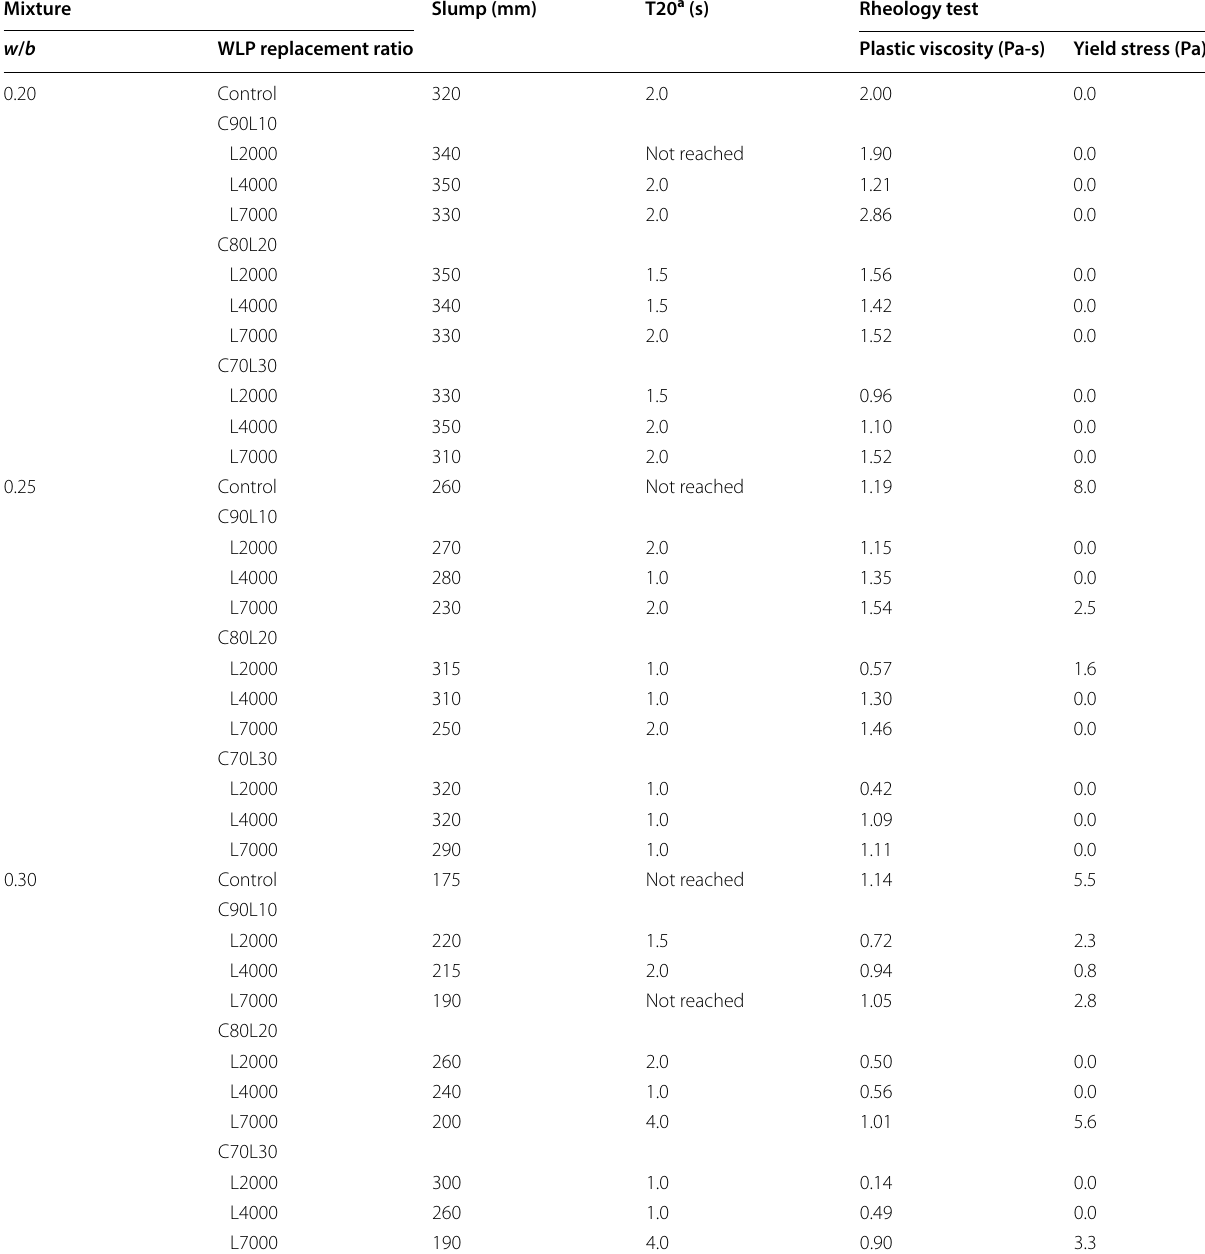
Table 5 Summary of the fluidity test